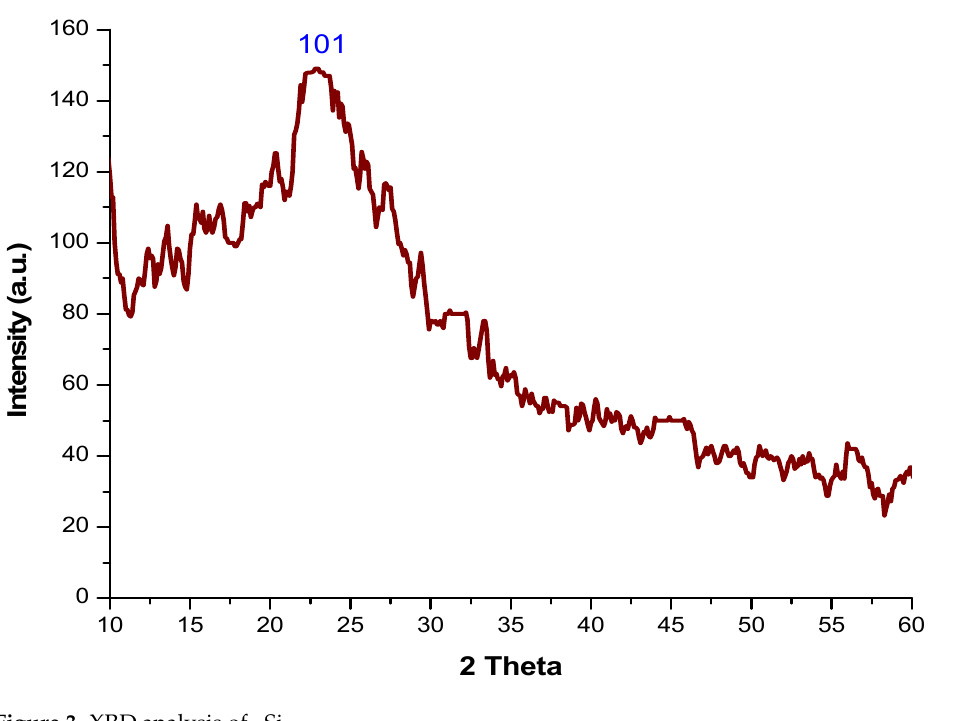
Figure 3. XRD analysis of n Si.